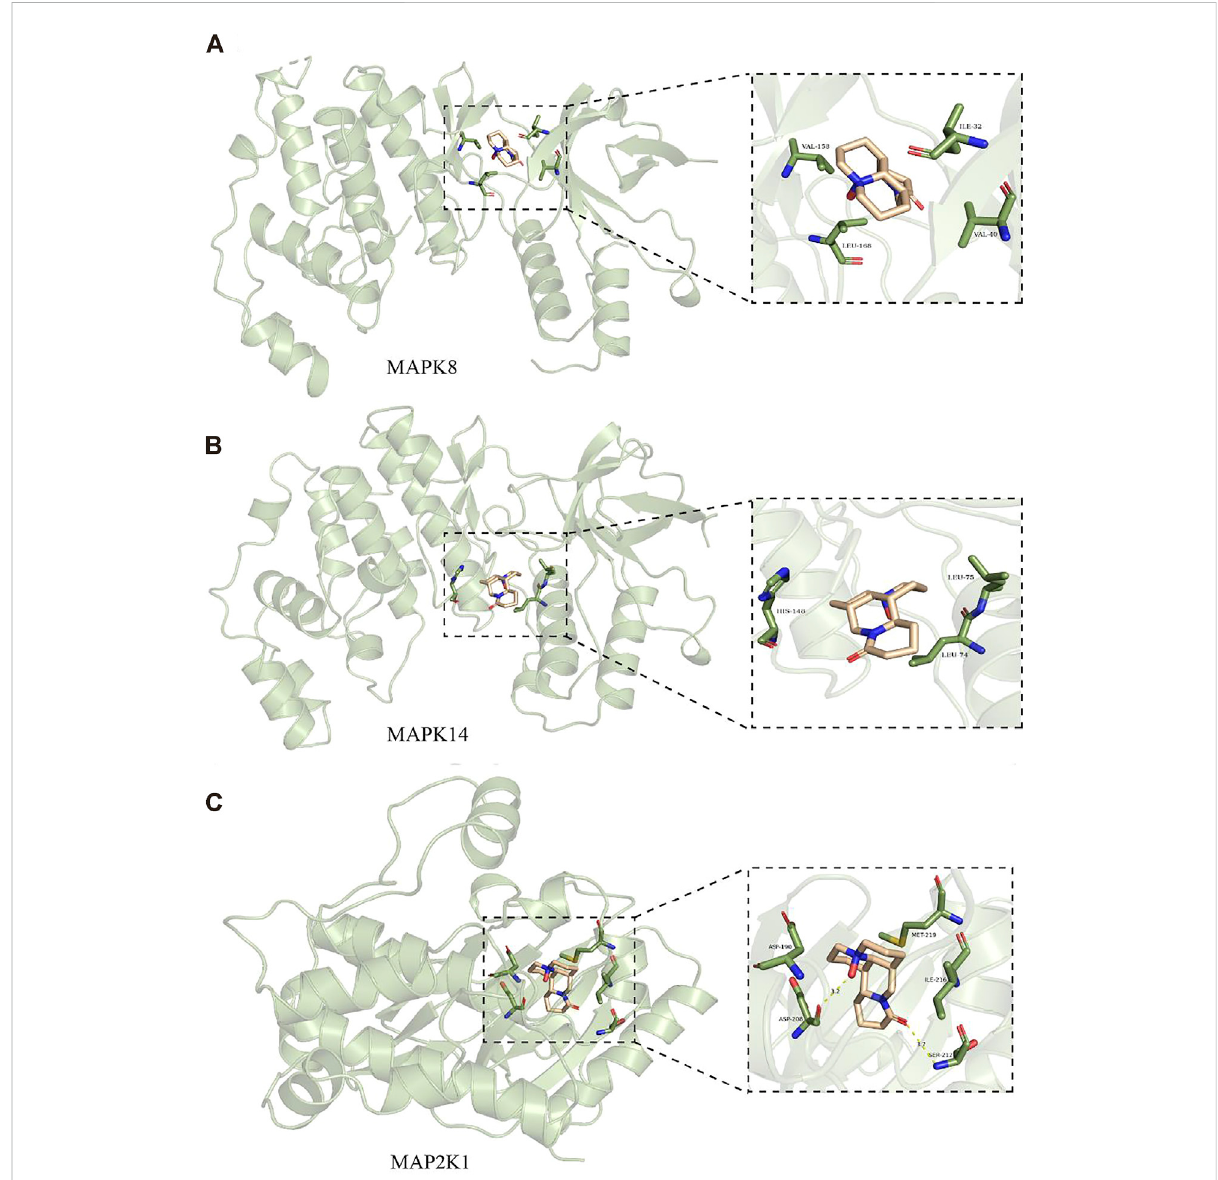
FIGURE 6 Molecular docking models of MAPK8, MAPK14, and MAP2K1. (A) are OBIT and MAPK8 docking mode and the interaction plane diagram. (B) are ONIT and NIAPKI4 docking model and the interaction plane diagram. (C) were OMT and MAP2K1 docking model and the interaction plane diagram.